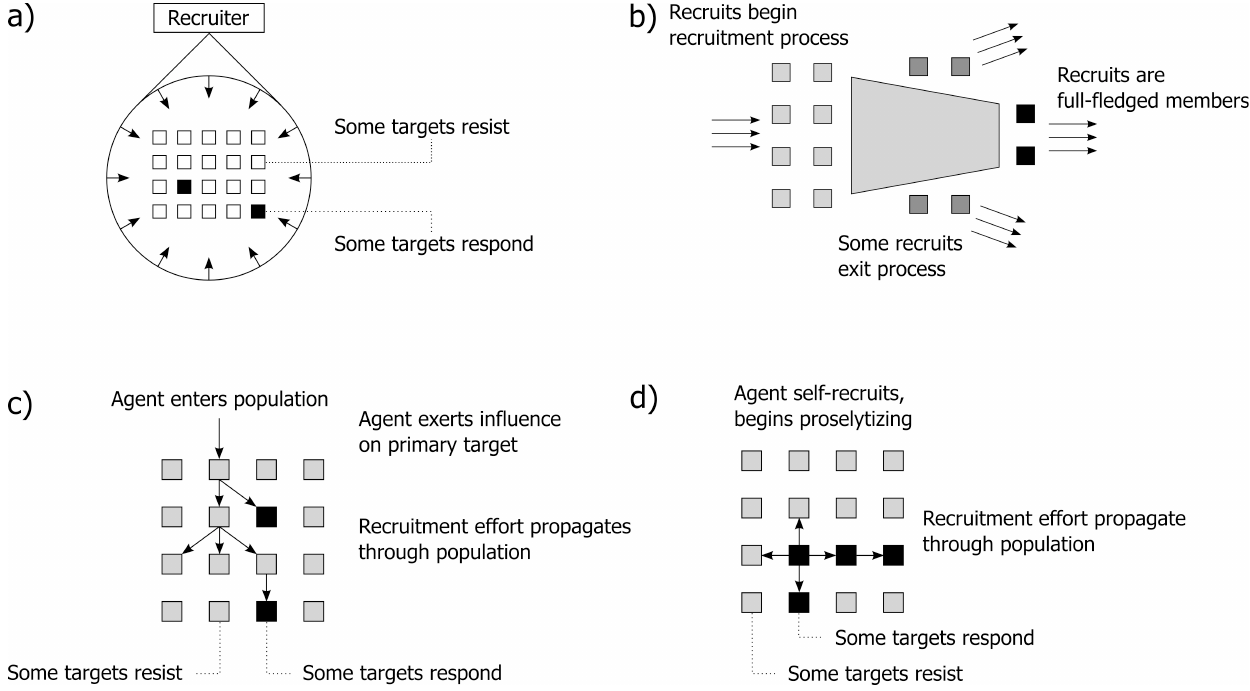
Figure 1. The four different models of recruitment as proposed by Gerwehr and Daley ([40], pp. 73–89): a) The Net; b) The Funnel; c) The Infection; d) The Seed Crystal.